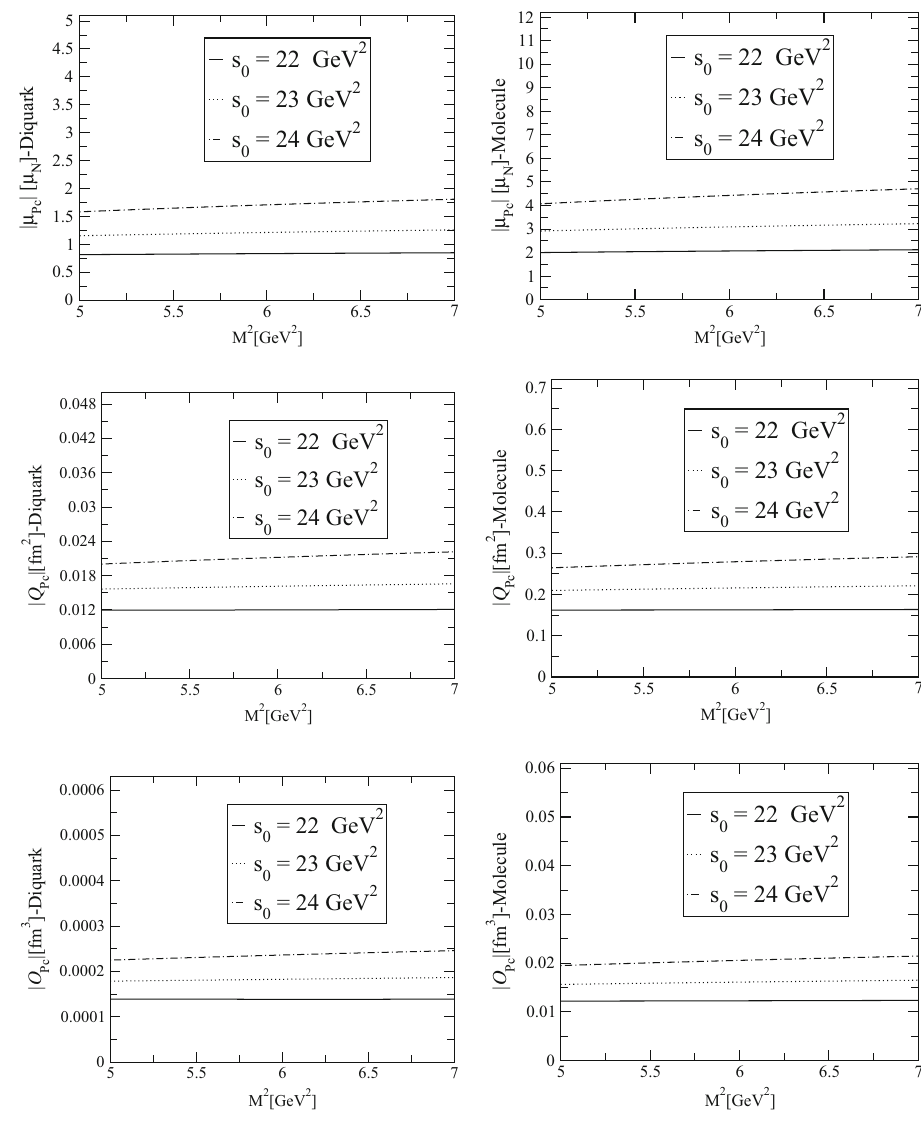
Fig. 1 The dependence of the magnetic dipole, electric quadrupole and magnetic octupole moments for P c pentaquark; on the Borel parameter squared M 2 at different fixed values of the continuum